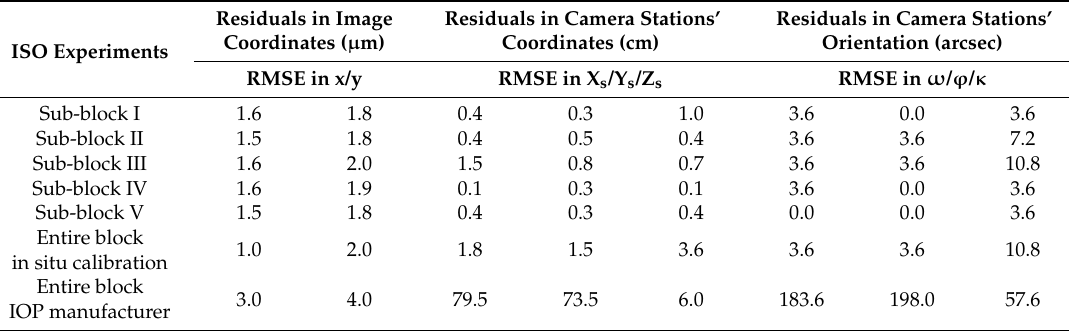
Table 3. Main results of the residuals analyses of the seven integrated sensor orientation (ISO)